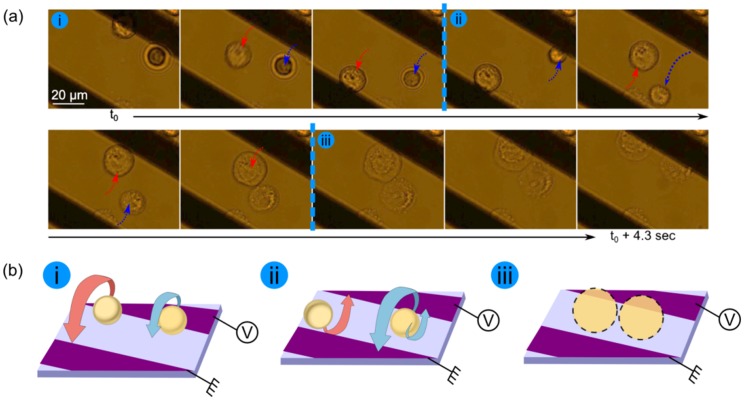
Time-lapse sequence images of cell destruction in conditions of dominant ACEO and ETE (f  =  1 kHz, Vpp  =  8 V, σm  =  2 10−4 S/m) (a) picture of HEK cells taken in a microfluidi chip and (b) schema of the observed motions.Cells are dragged in bulk rolls and the membrane rapidly breaks.